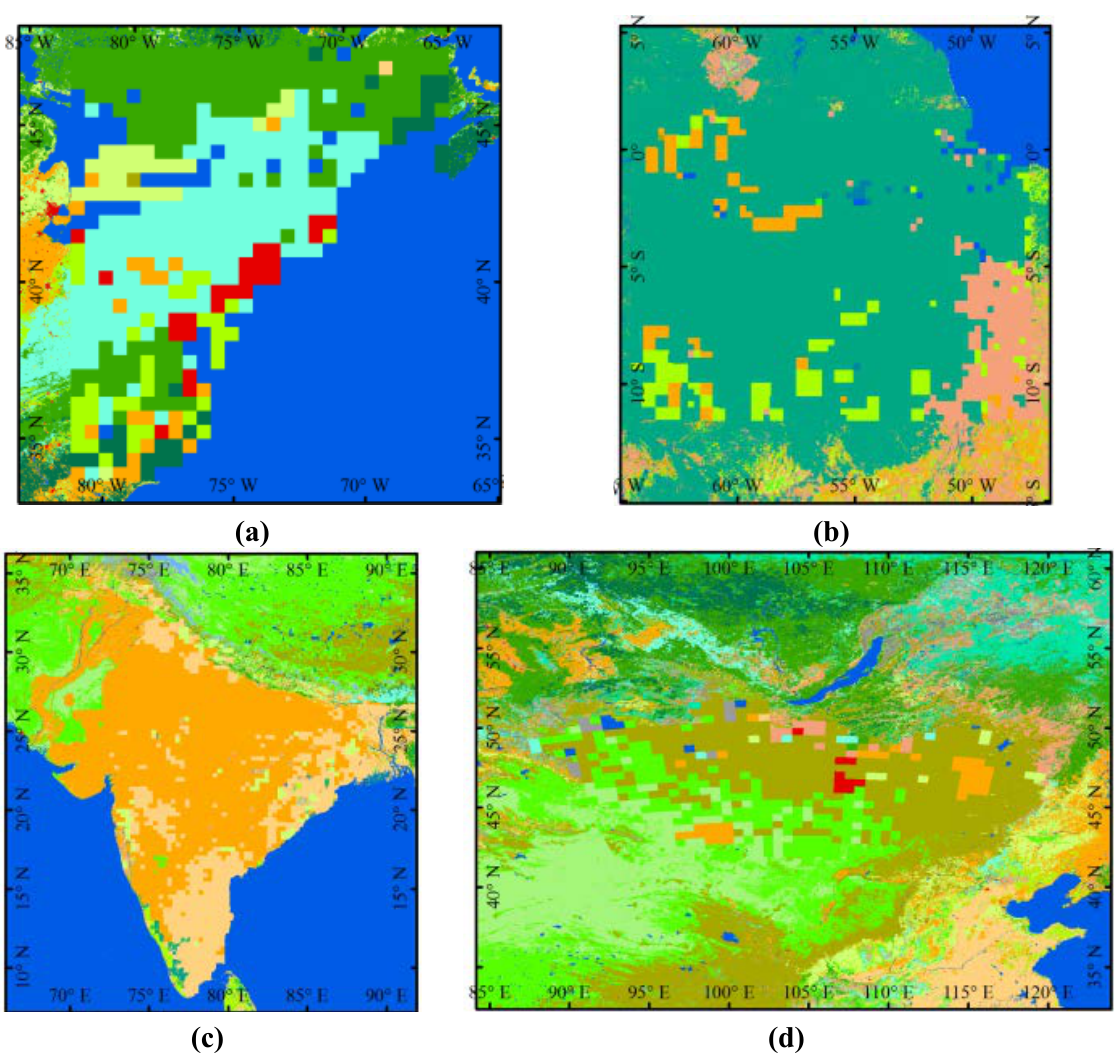
Figure 3. Predicted underlying land use/cover data in 2050 of the four case